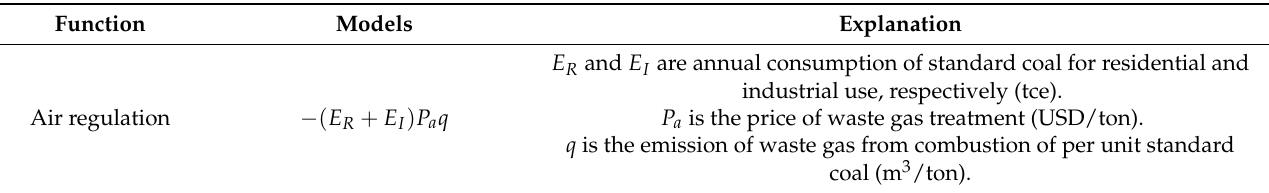
Table 1. Methods of assessment ESV for artificial surface.